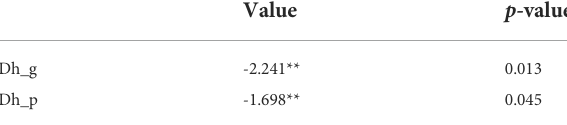
TABLE 6 Cointegration test Westerlund